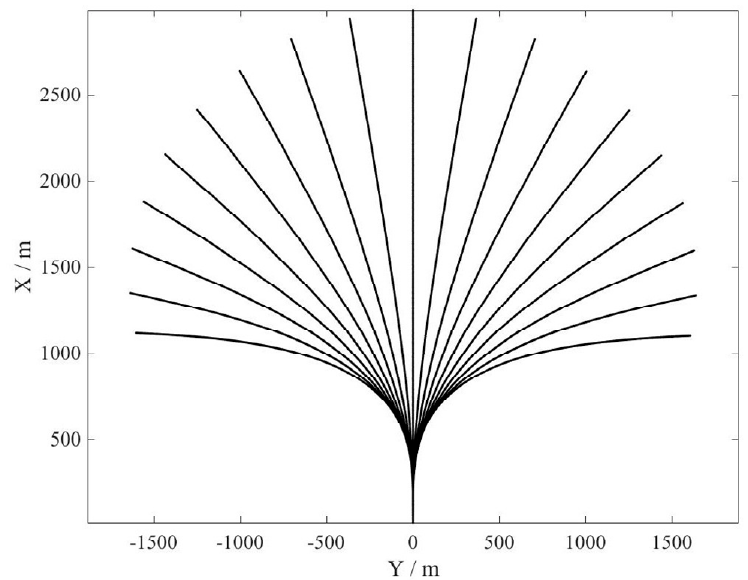
Figure A3. Simulation of the course control system.